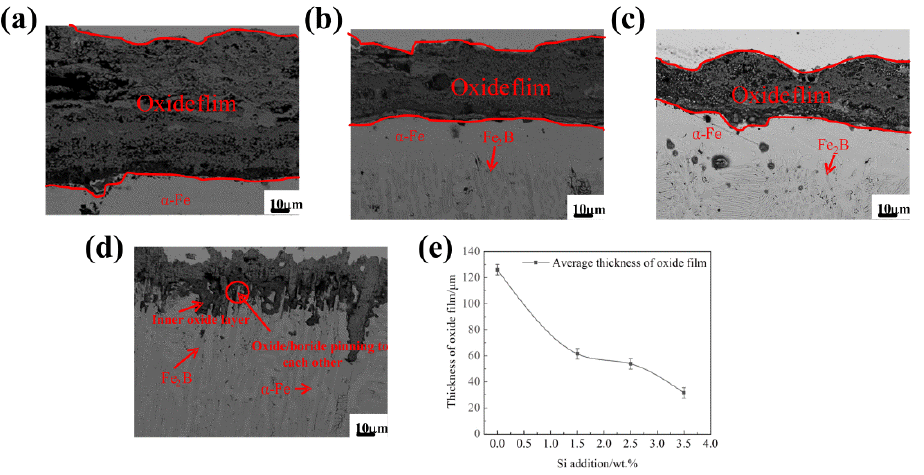
Figure 9. The BSE micrographs of the cross-section of Fe 2 B // samples oxidized for 60 h at 1073 K: ( a ) alloy A1, ( b ) alloy A2, ( c ) alloy A3, ( d ) alloy A4, ( e ) the thickness of cross-sectional oxide